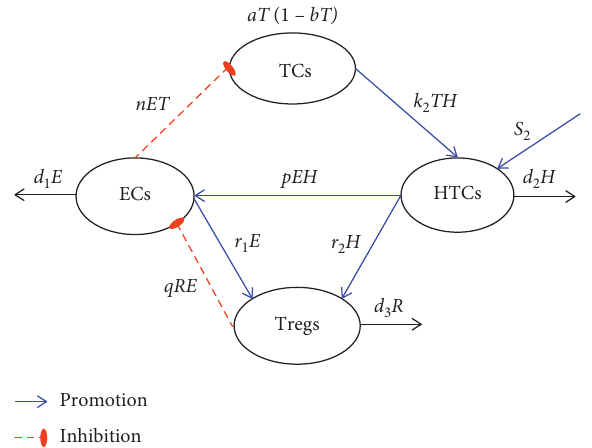
Figure 1: A diagram of interactions among the different cell populations in model